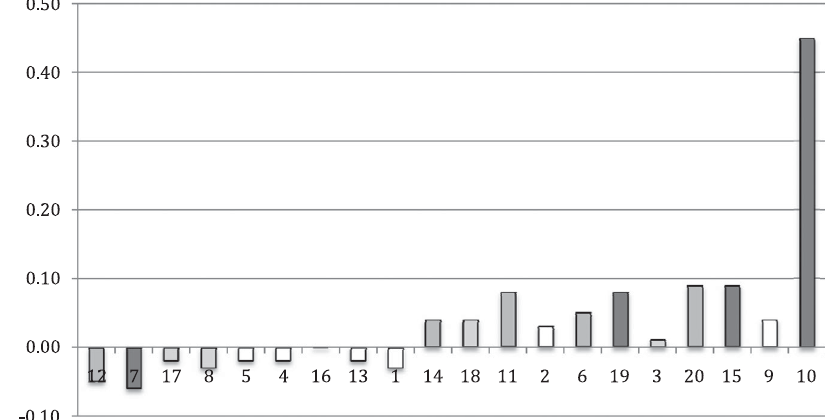
FIG. 3. Estimated coefficients for the parameter instruction in the regression models ( β shaded dark gray, medium gray, and light gray indicate effects significant at the 1%, 5%, and 10% levels,